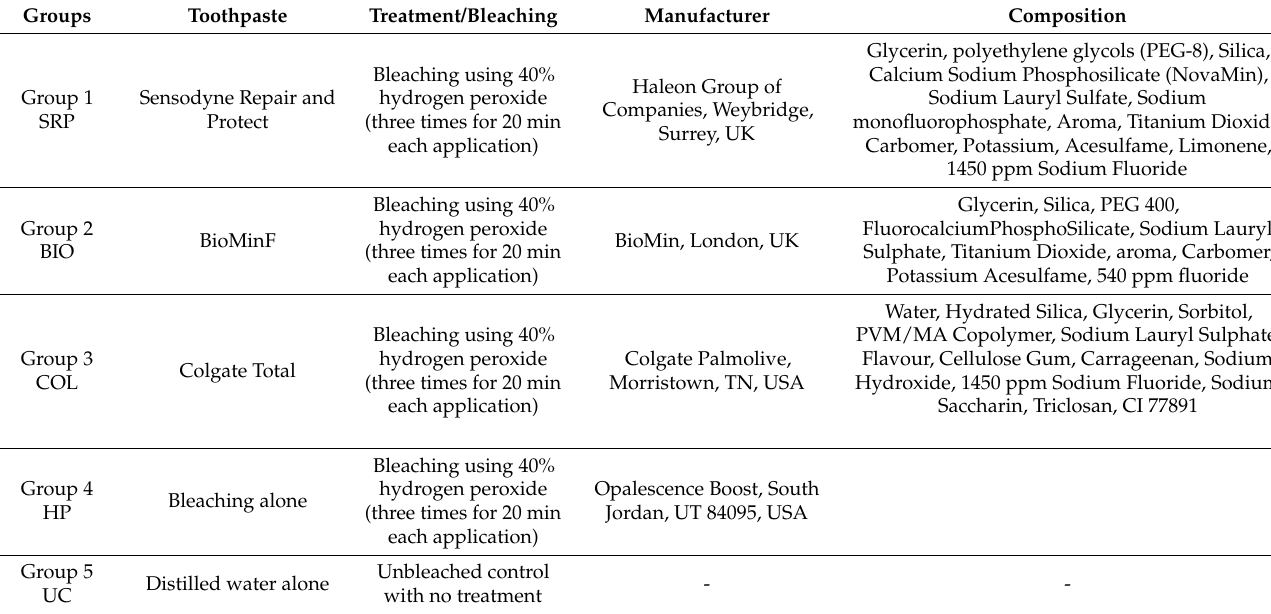
Table 1. Study groups and compositions of each